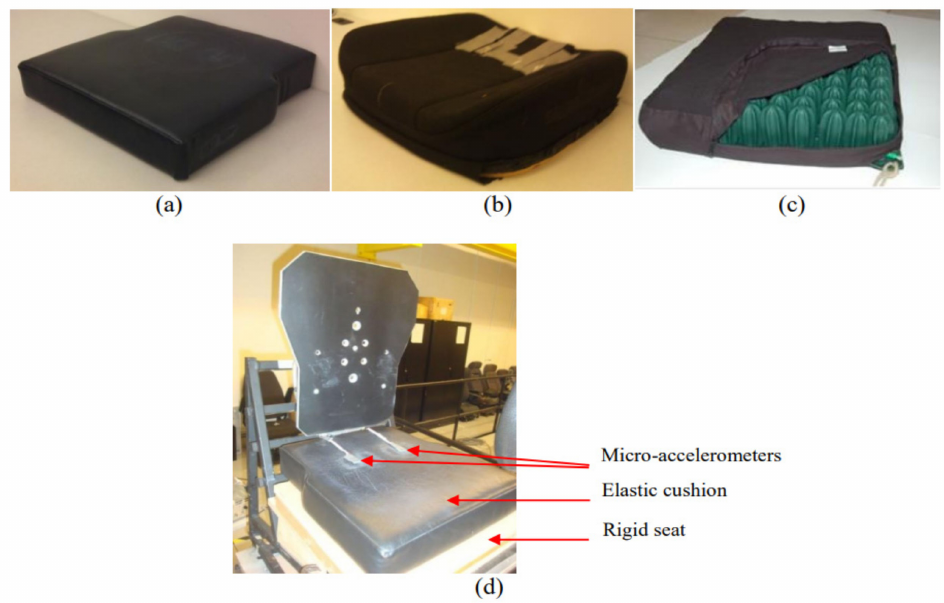
Figure 1. Selected cushions and test seat: ( a ) flat PUF (seat A); ( b ) contoured automotive PUF (seat B); ( c ) inflatable air-bubble cushion (seat C); and ( d ) placement of accelerometers on seat cushion A. Three different levels (0.25, 0.50 and 0.75 m/s 2 RMS) of white noise random